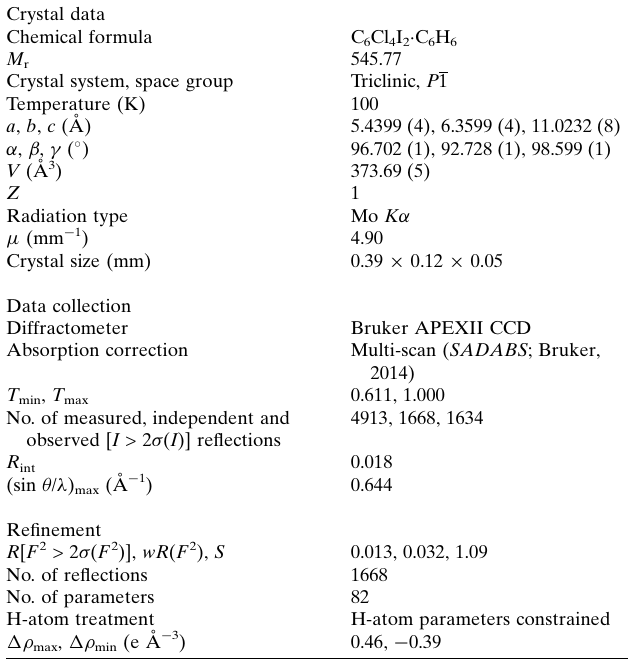
Table 1 Experimental details. Crystal data Chemical formula